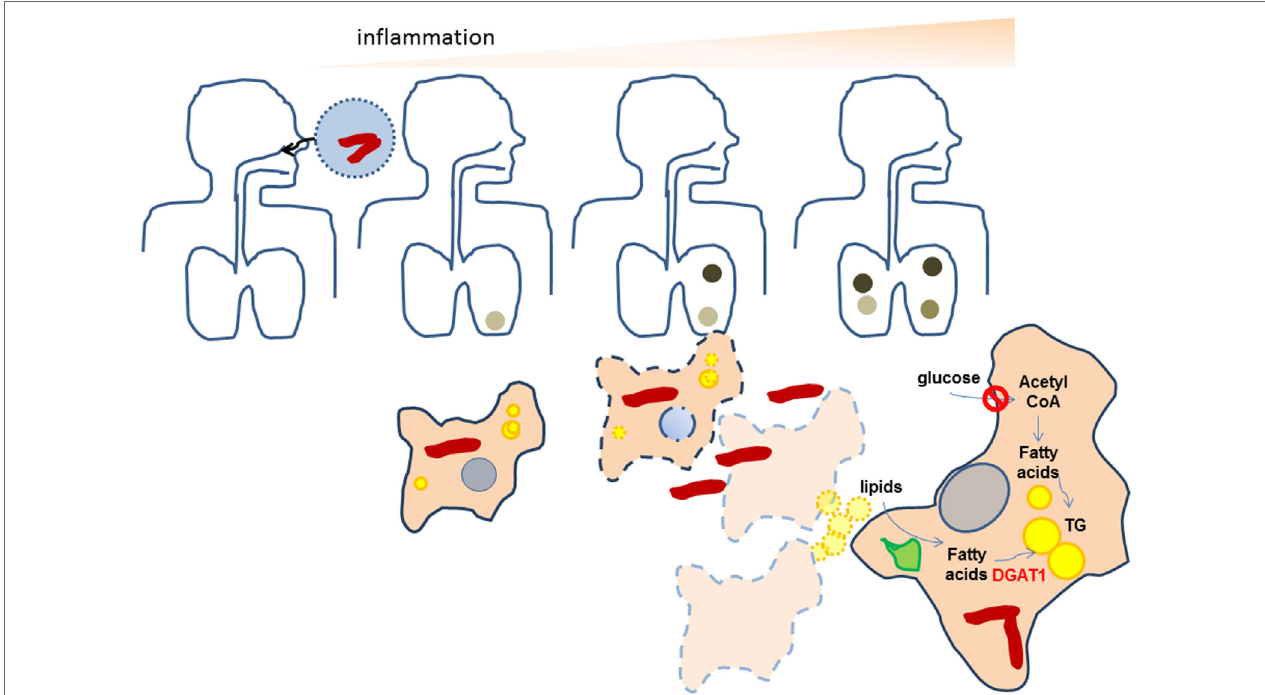
FigUre 7 | Proposed scheme for the amplification of inflammation as a result of neosynthesis of triglycerides (TGs) in bystander foamy macrophages in TB. Bacteria are indicated as red rods while lipid droplets are indicates as yellow spheres. Darkened regions in the lung indicate granulomas. During initial infection of macrophages with Mycobacterium tuberculosis (Mtb), low levels of TGs are present in infected macrophages. The inflammatory response of macrophages recruits immune cells that help in granuloma formation. As bacteria multiply, both host and bacterial factors may synergize to bring about necrosis of infected cells, leading to formation of necrotic granulomas. Macrophages surrounding the necrotic center differentiate to TG-rich (yellow) foamy macrophages using lipids available from the necrotic cells, by first degrading them using lysosomal lipases (green). In doing so, they downregulate their glucose uptake and do not rely on de novo fatty acid synthesis for the increase in TG levels. Upon infection with Mtb, these necrosis-associated foamy macrophages release higher levels of pro-inflammatory mediators. The pro-inflammatory response of macrophages is dependent on the increased TG levels. The evolution of granulomas to necrotic granulomas, thereby amplifies the inflammatory